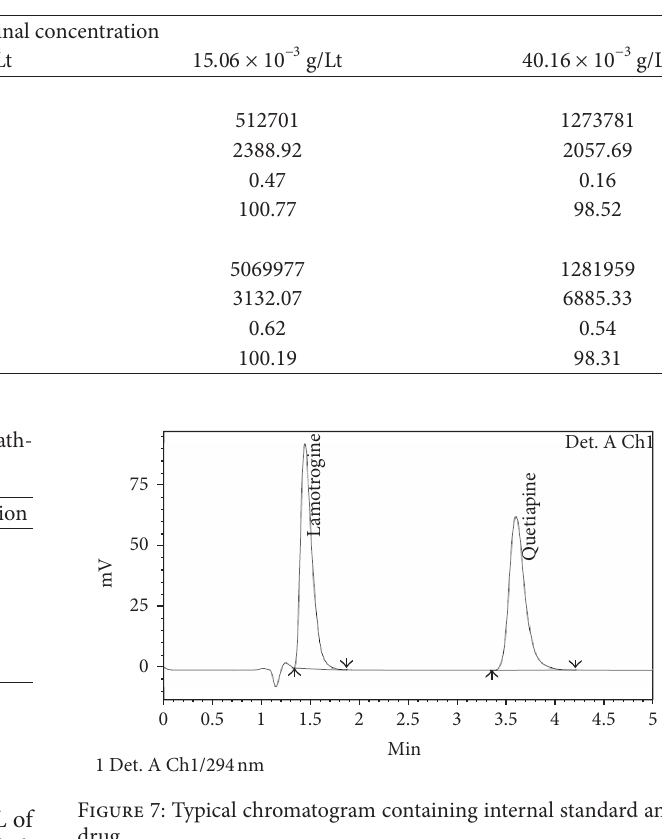
F 7: Typical chromatogram containing internal standard and